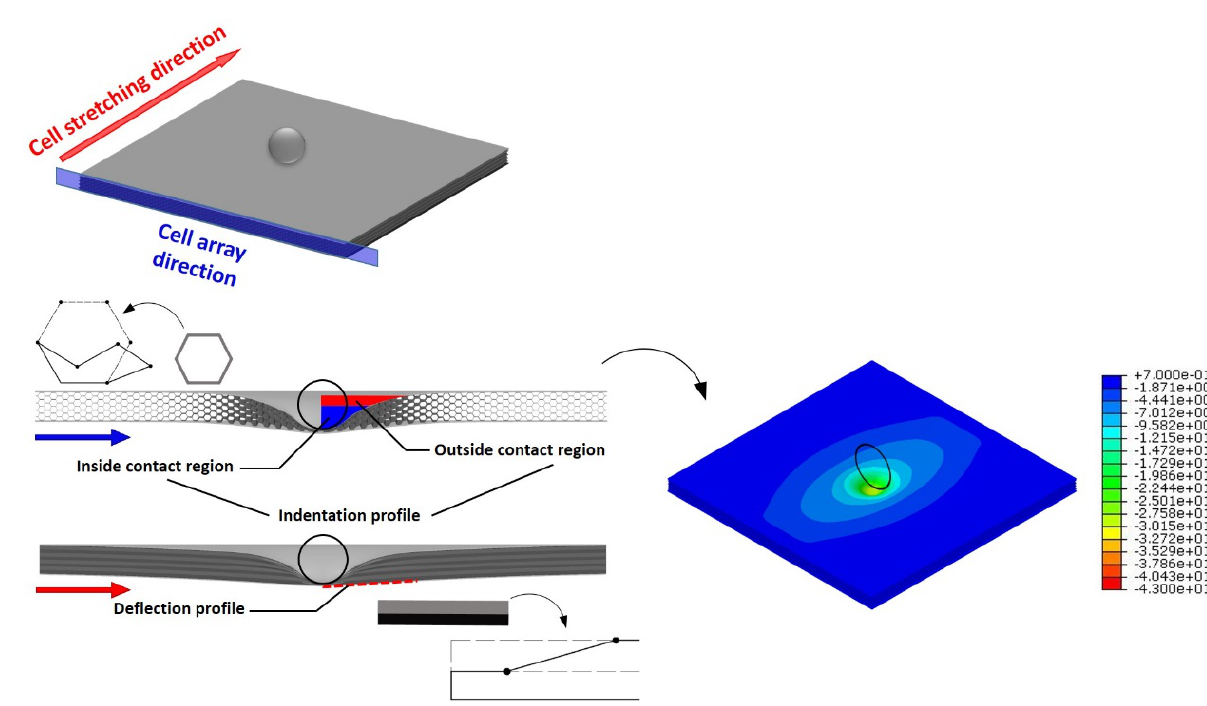
Figure 7: Local impact modes of sandwich panel with in-plane honeycomb under 50 m/s projectile (take Poisson’s ratio 1 as example).